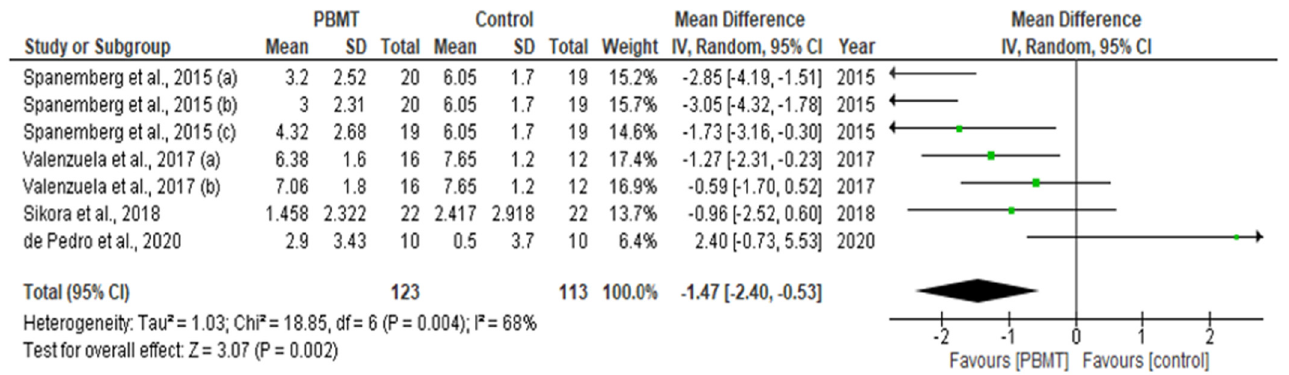
Figure 5. Forest plot for primary outcome qualitative pain/burning sensation reduction assessment (VAS) from baseline up to the final follow-up timepoint.